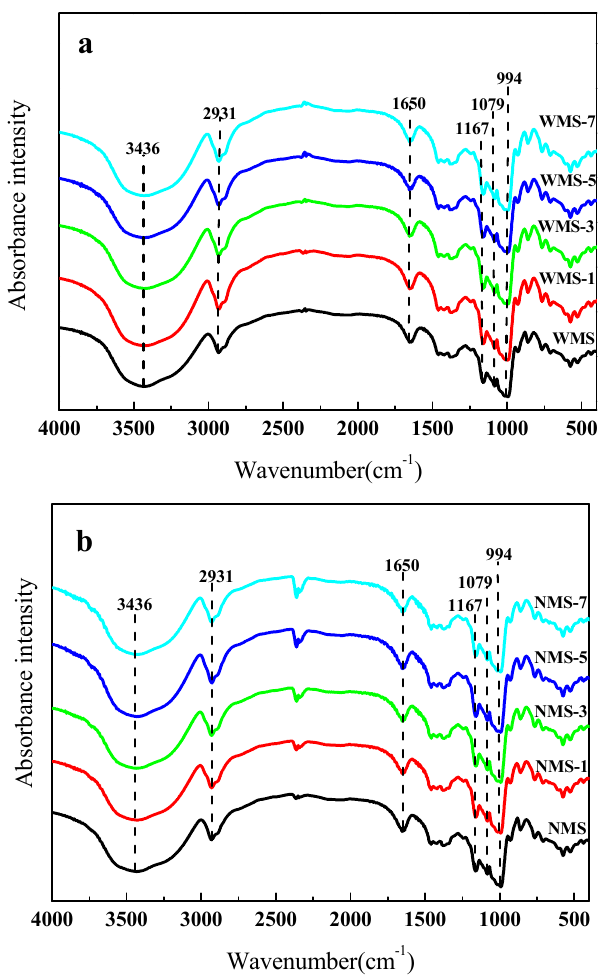
Figure 4. Fourier-transform infrared spectroscopy (FTIR) spectra of maize starch samples treated by APPJ. ( a ) Waxy maize starch ( b ), normal maize starch.